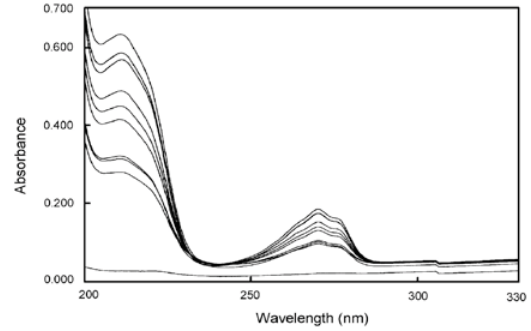
Figure 2. Photodegradation of phenol on ZnO. The UV- vis spectra of illuminated phenol diluted 200-fold stepwise and recorded at 0, 15, 30, 45, 60, 75, 90, 105, 120, 240 min ( ↓ ). [Phenol] = 2.0 mM, catalyst loading = 0.10 g, λ = 365 nm, I = 25.4 μeinstein L -1 s -1 , airflow ] = 12.6 mg L -1 , phenol solution = 25 rate = 7.8 mL s -1 , [O 2 dissolved